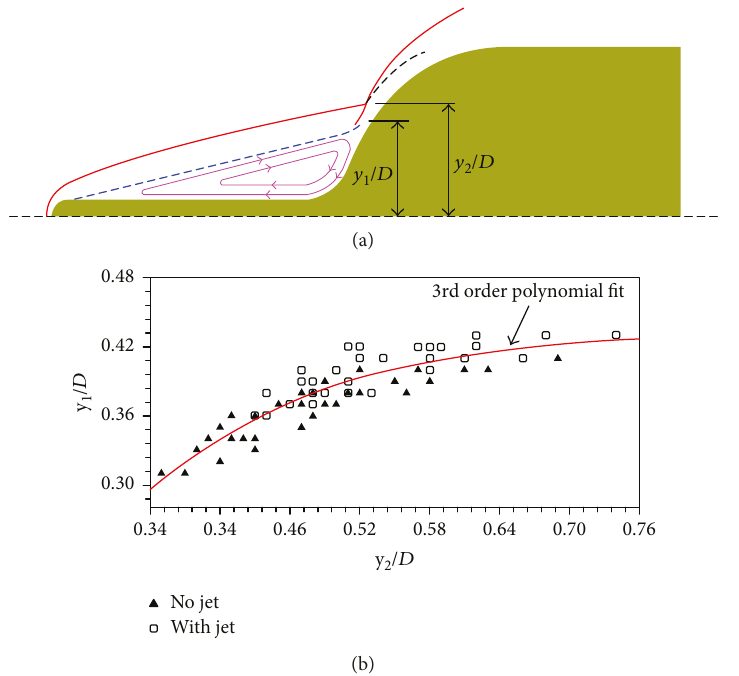
Figure 17: Two nondimensionalized parameters y de fi nitions; (b) distribution of the two parameters and a third order polynomial fi